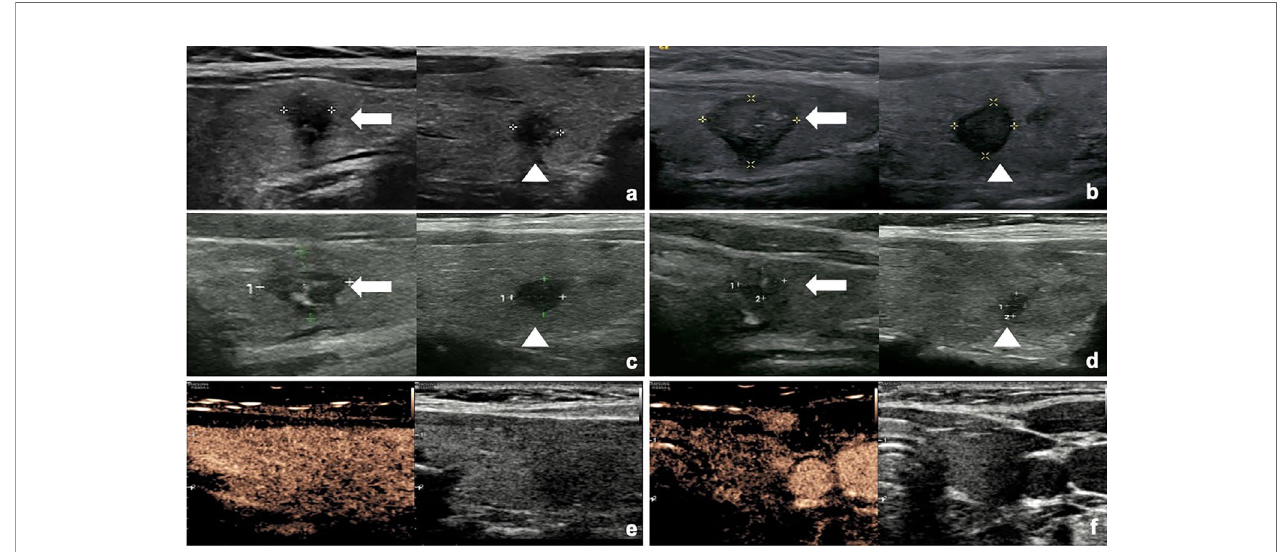
FIGURE 3 | The US and CEUS images of a 32-year-old female with bilateral PTMC during the follow-up. (A) Before RFA, two PTMC lesions were con fi rmed by CNB. One tumor was located in the left lobe with an initial volume of 78.54 mm 3 (arrow) and the other one was in right lobe with an initial volume of 65.45mm 3 (arrowhead). (B) At 1 month after RFA, the volume of left tumor (arrow) was 898.47 mm 3 and the volume of right tumor (arrowhead) was 234.57 mm 3 . (C) At 3 months after RFA, the volume of left tumor (arrow) was 226.19 mm 3 and the volume of right tumor (arrowhead) was 78.54 mm 3 . (D) At 6 months after RFA, the volume of left tumor (arrow) was 50.26 mm 3 and the volume of right tumor (arrowhead) was 12.57 mm 3 . (E, F) At 12 months after RFA, these two ablated tumors both disappeared.